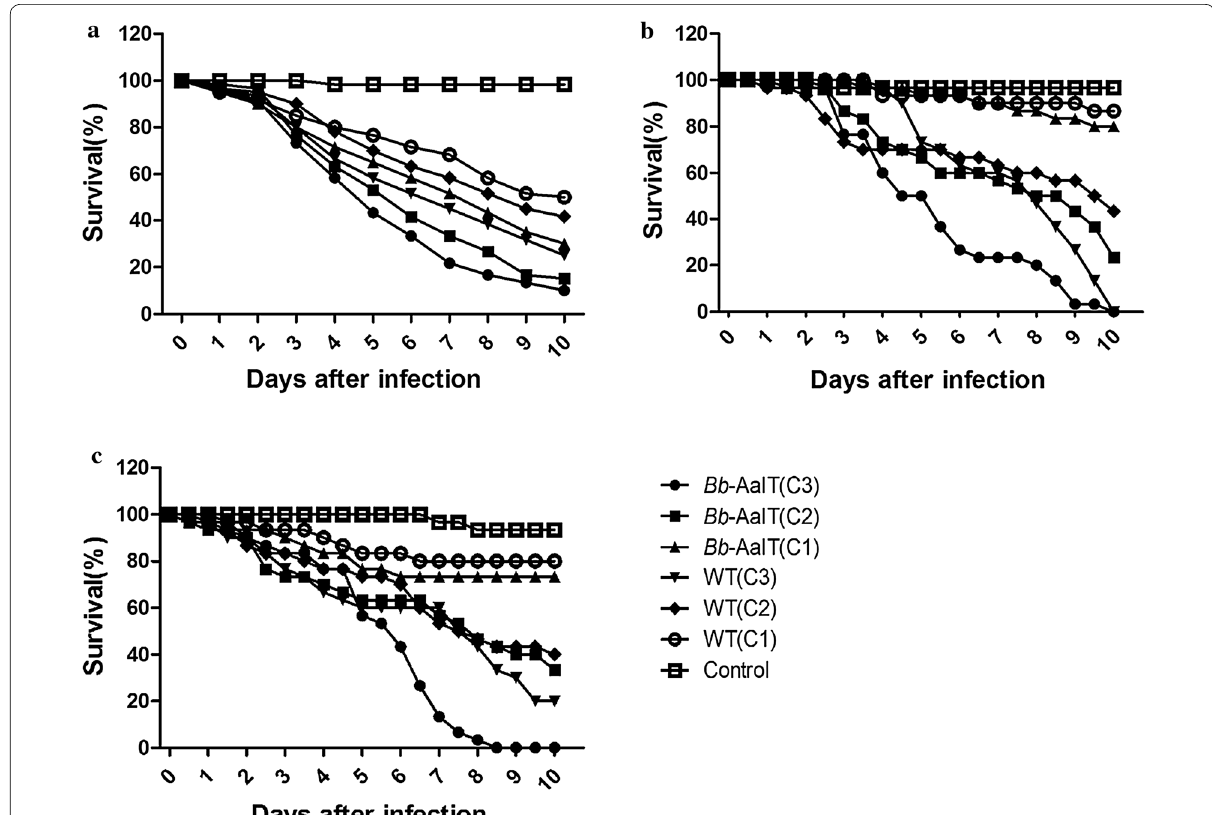
Fig. 2 Survival curves of larval and adult mosquitoes for different Bb ‑AaIT and WT treatments. a The survival curve of Aedes albopictus larvae when treated with (C1) 1 10 5 , (C2) 1 10 6 and (C3) 1 10 7 conidia ml − 1 suspensions of Bb ‑AaIT and the WT. b The survival curve of Aedes albopictus × × × female adults that were infected by conidia ingestion with (C1) 1 10 5 , (C2) 1 10 6 and (C3) 1 10 7 conidia ml − 1 suspensions of Bb ‑AaIT and WT. × × × c The survival curve of Aedes albopictus female adults that were infected through cuticle contact with 3 ml of (C1) 1 10 6 , (C2) 1 10 7 and (C3) × × 1 10 8 conidia ml − 1 suspensions containing Bb ‑AaIT and WT that were sprayed on 50 cm 2 filter ×